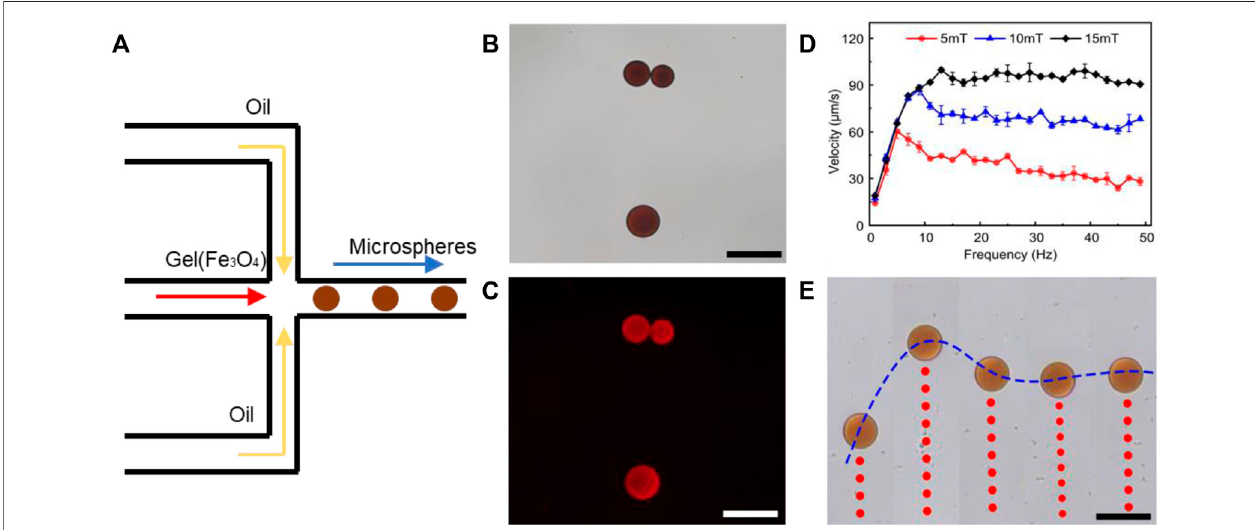
FIGURE 3 | Synthesis and characterization of magnetic-driven hydrogel microrobots. (A) Schematic of the microrobot synthesis. (B) Microrobot characteristics under bright fi eld. (C) Microrobot characteristics under dark fi eld and the EPZ015666 stained by rhodamine was detected as red fl uorescence. (D,E) By enhancing the intensity and frequency of the magnetic fi eld, the velocity of microrobots was growing faster. Scale bar of B , C , and E = 50 μ m.